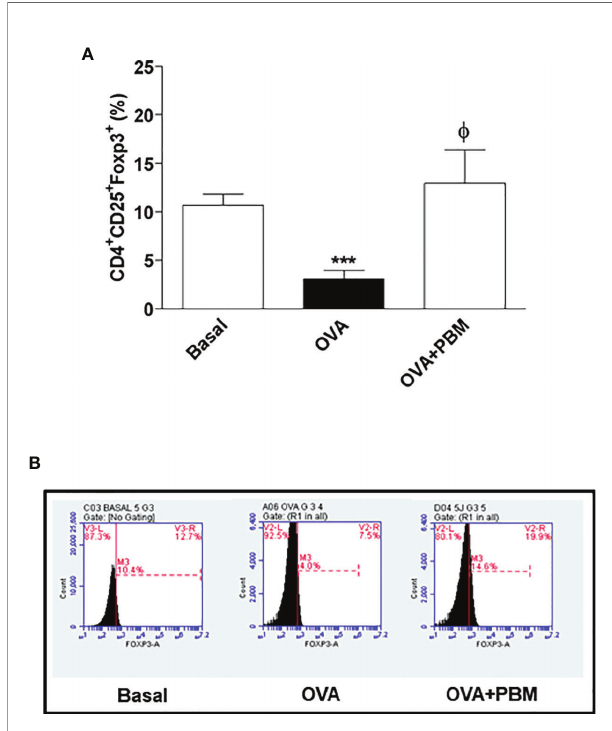
FIGURE 8 | Effect of photobiomodulation on the percentage of CD4+CD25 +Foxp3+ Treg cells inBALF. (A) Cellswere expressed inMFI andlivecells were selected and then forward versusside scatter (FSC vs. SSC) gatingwas used to identify cells ofinterest based on size and granularity (complexity). The gates strategy was used,where the totalcellpopulation in BALFwas selected,and then CD4+ T lymphocytes, CD25+ andFoxp3+.Basalgroup, n = 5; OVA group, n = 7; PBMgroup, n = 5; OVA+ PBM, n = 8. Two independent sets of experiments were carriedout. The histograms represent the allgroupsevaluated (B) . Data represent mean ± standard error (SEM). ***p < 0.001 inrelation to the Basal group. f p < 0.001 in relation to the OVA